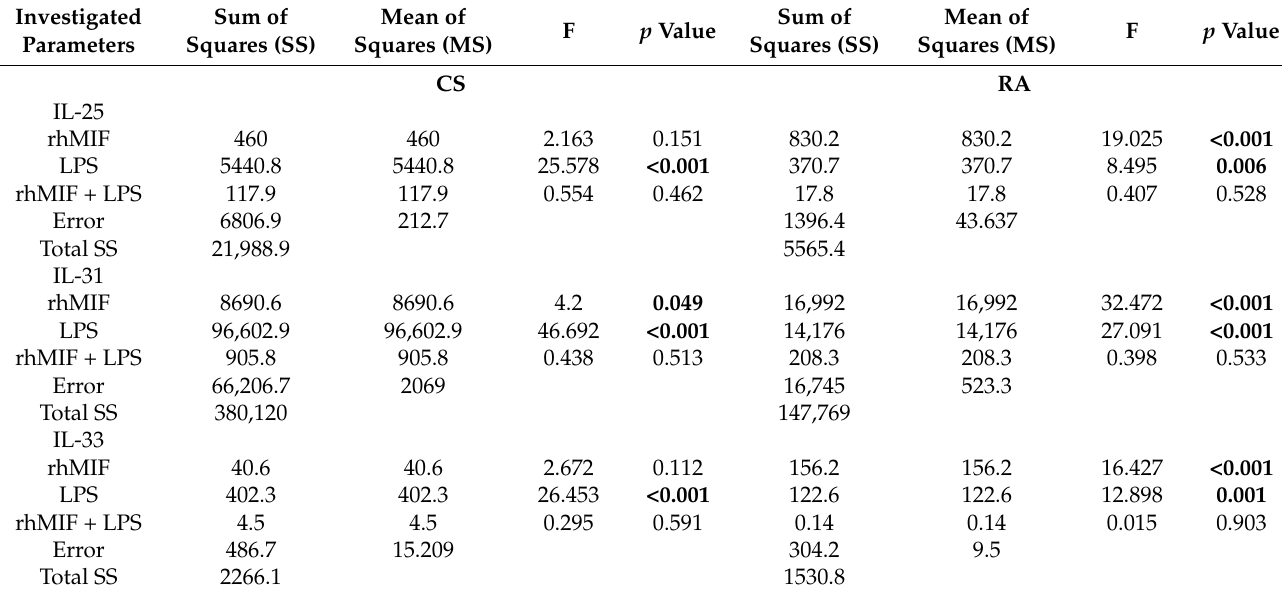
Table 1. ANOVA parameters for the characterization of the 2 × 2 factorial design for the effect of LPS plus rhMIF on IL-25, IL-31, and IL-33 secretion from PBMC.